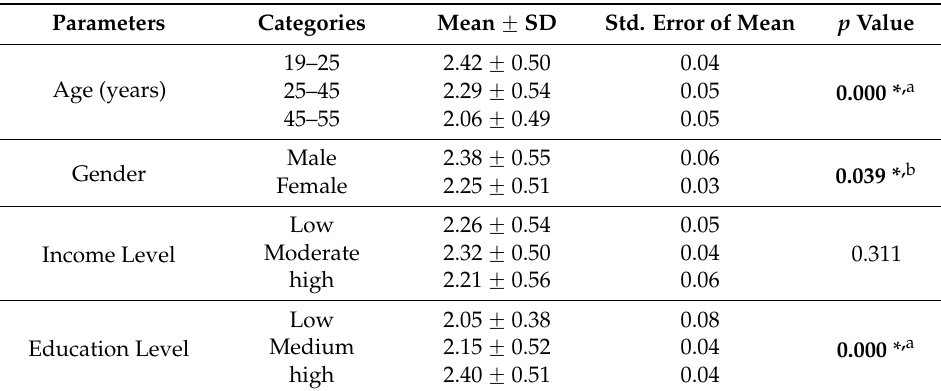
Table 4. Factors associated with nutrition